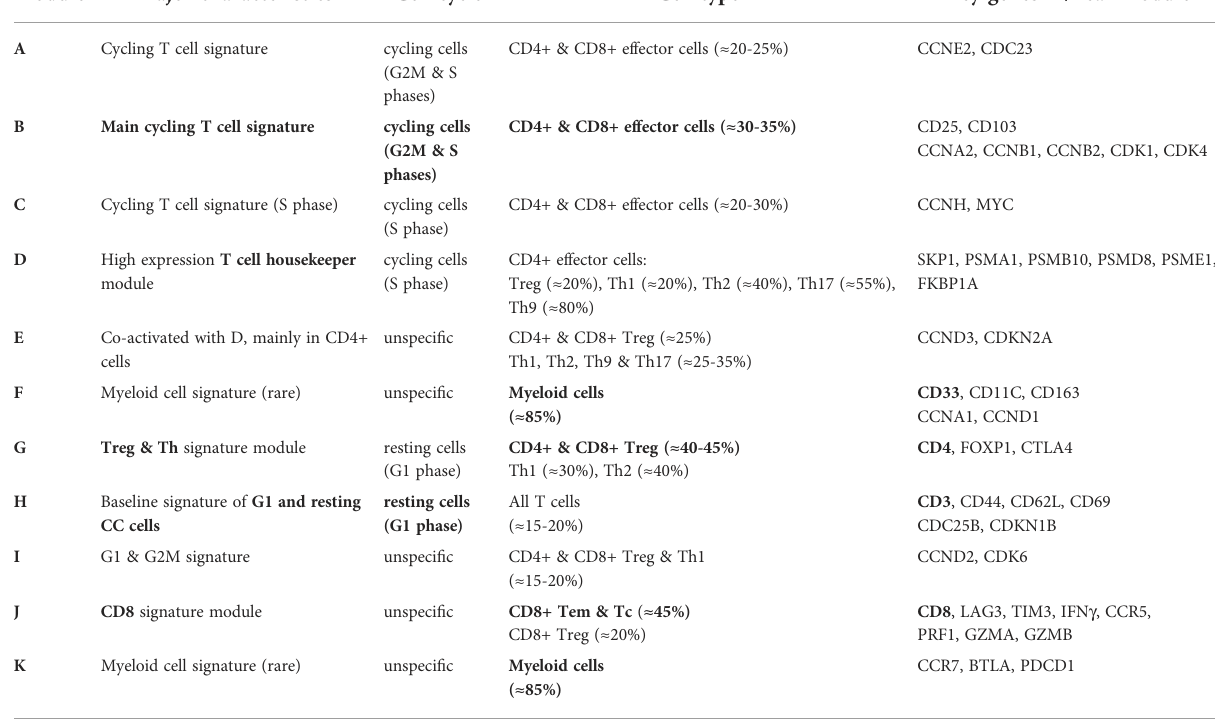
TABLE 1 Characterization of the expression